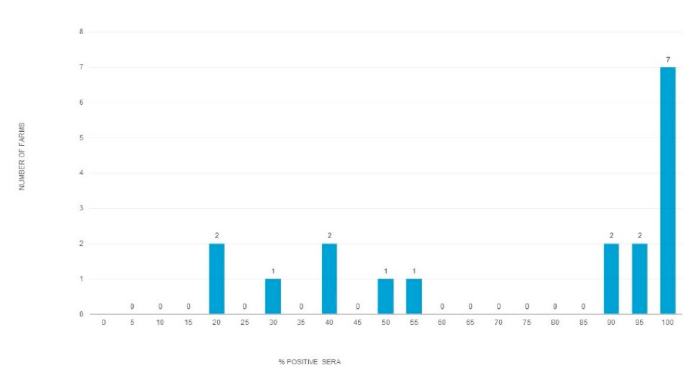
Figure 3. Variance between farms in HEV seroprevalence among slaughter-aged pigs . The table includes data collected from 17 farms and 1 slaughterhouse during the period of 2017–2020. The chart represents the number of farms ( Y -axis) based on the percentage of positive sera per farm ( X -axis).